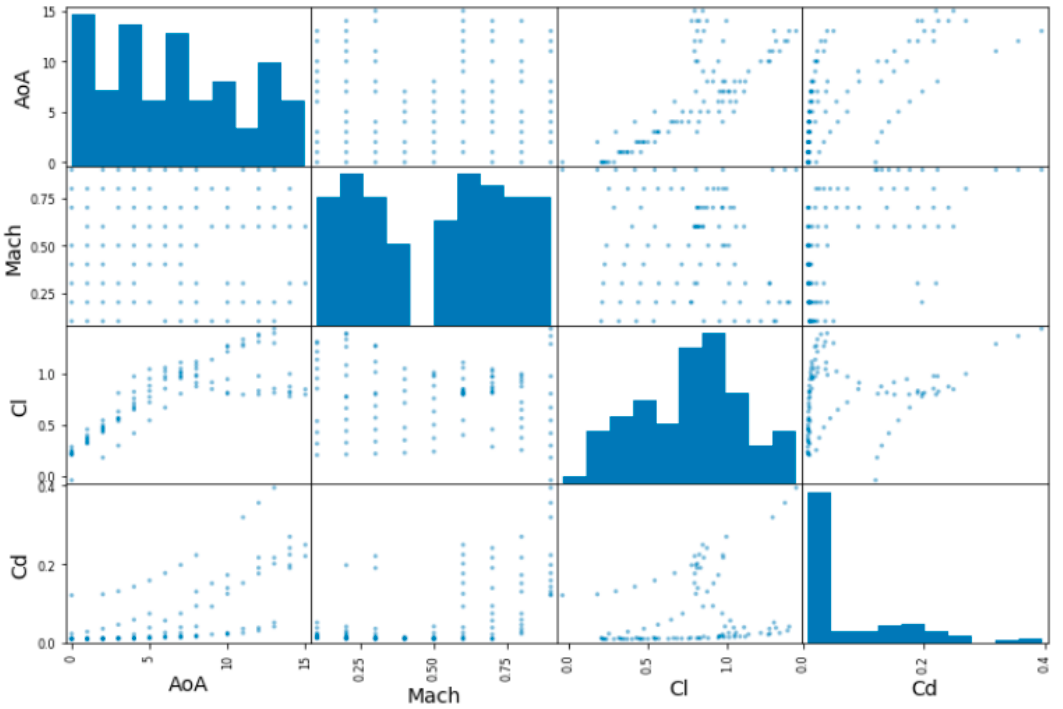
Figure 7. Exploring training set in the RAE2822 database (correlation matrix plot).